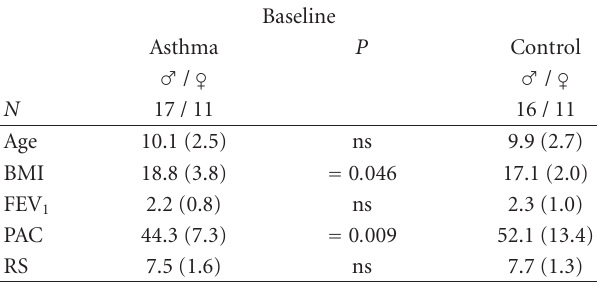
Table 2: Descriptive information, mean ( ± SD), of study popula- tion by